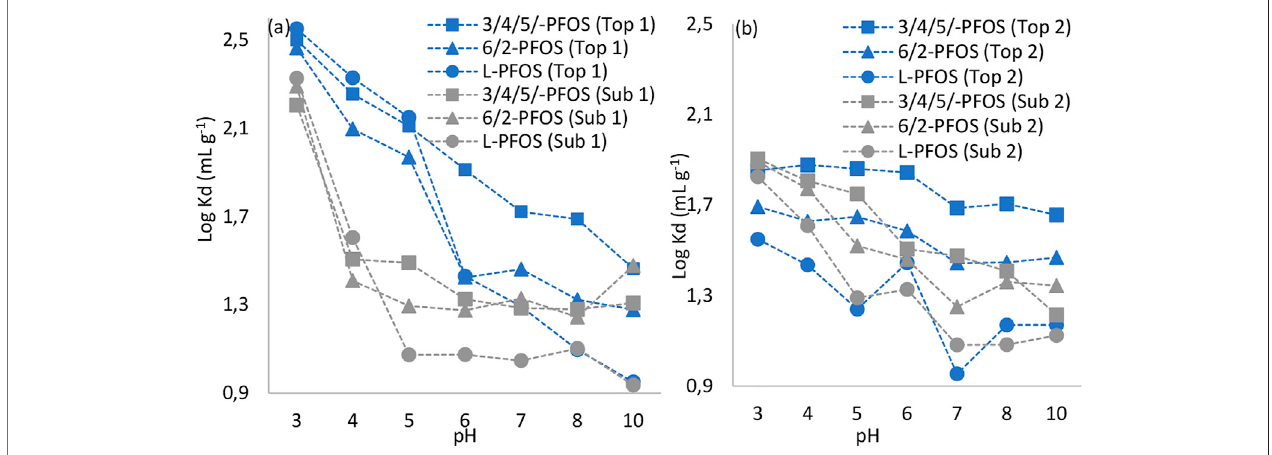
FIGURE 2 | Logarithmic sorption coef fi cients of PFOS isomers onto soils as a function of pH: (A) sub and top soils taken at the area (1) and (B) sub and top soils taken at the area (2).